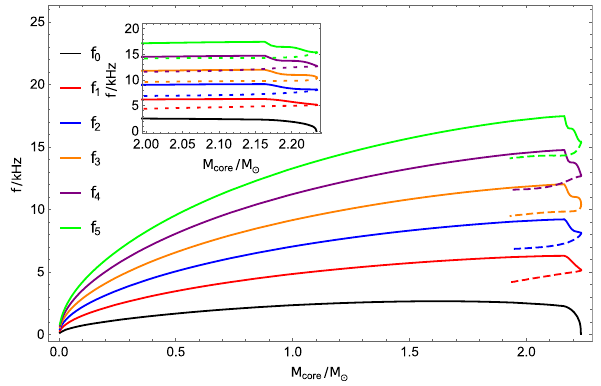
Fig. 4 The eigenfrequencies f n = ω n / 2 π of n = 0 , 1 , 2 , 3 , 4 , 5 modes versus mass of multiquark core at energy density scale (cid:3) s = 23 . 2037 GeV/fm 3 . Solid (Dashed) line represents the frequency of the MQ core in the stable (unstable) branch